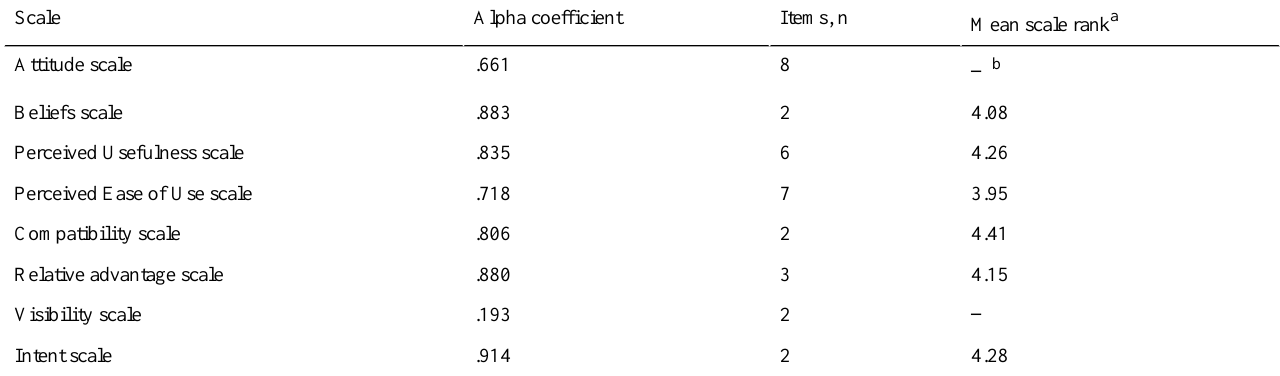
Table 2. Cronbach alpha coefficients for questionnaire by